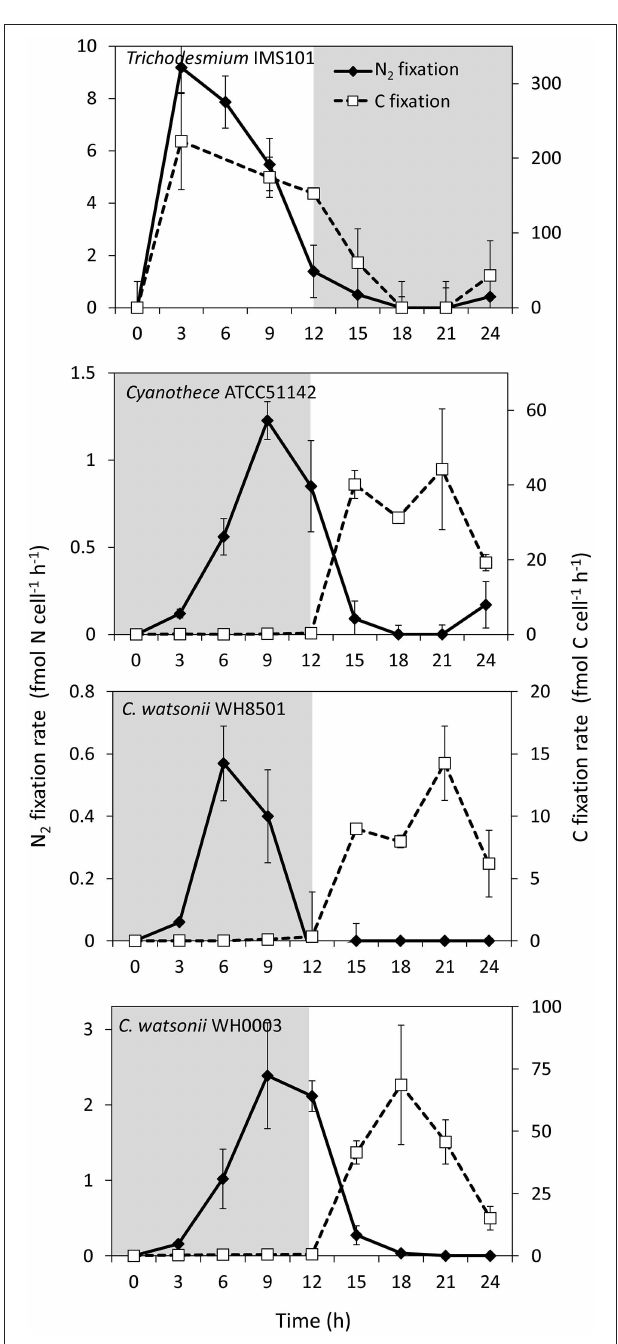
FIGURE 4 | Net N 2 and C fixation rates during exp 2 for each strain studied. Error bars represents the standard deviation of the triplicates cumulated with the analytical precision according to the propagation of errors. Gray areas represent the dark